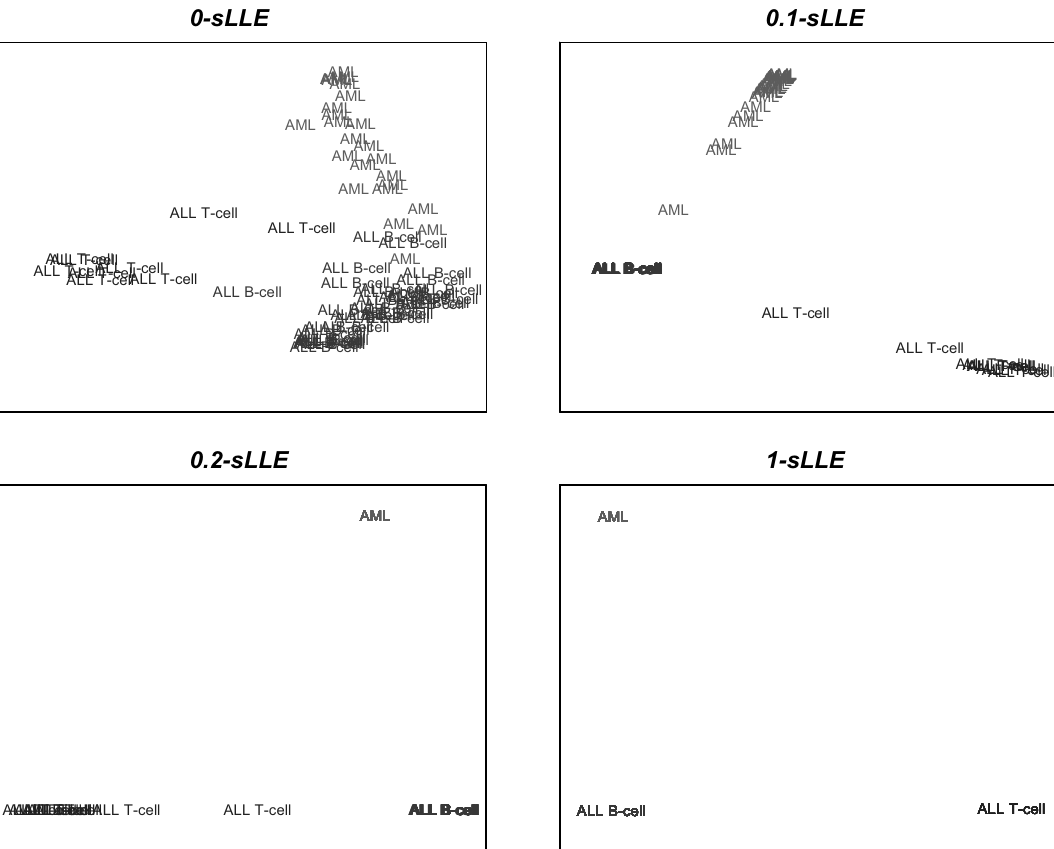
Figure 2 – (cid:68) - supervised LLE on Leukemia data set (Golub et al .,